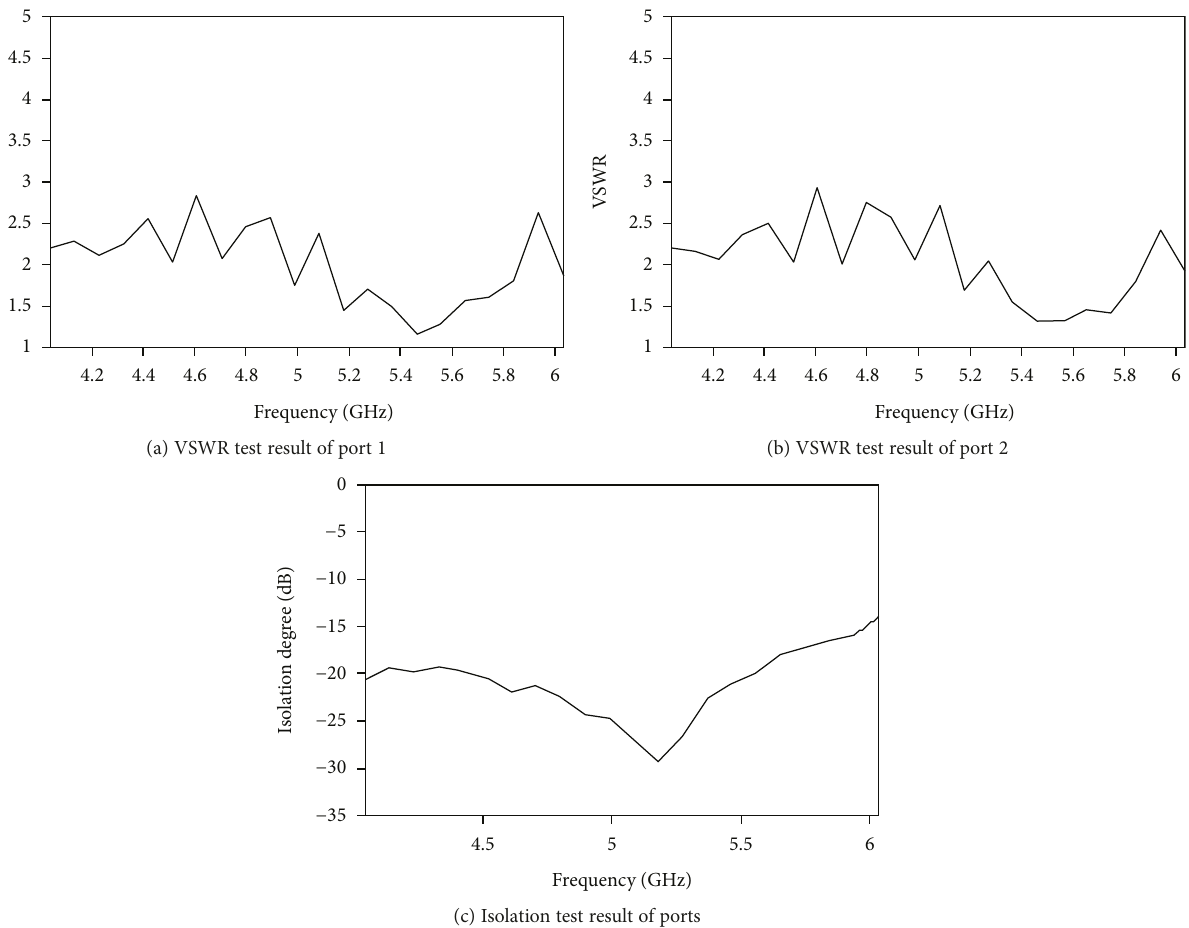
Figure 10: Photo of dual polarized antenna and test results of electronic principle.